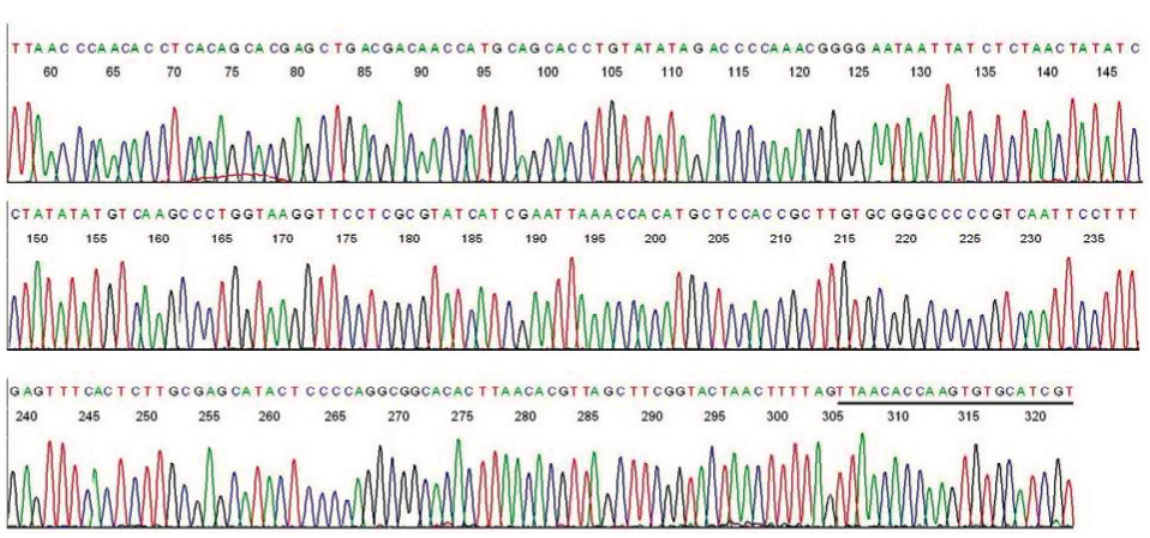
Figure 3. Base-calling sequencing electropherogram of an M1/M2 PCR amplicon showing part of a 357-bp segment of the 16S rDNA of B. burgdorferi (Figure 1, lane P). M2 was the sequencing primer. The M1 binding site is underlined.